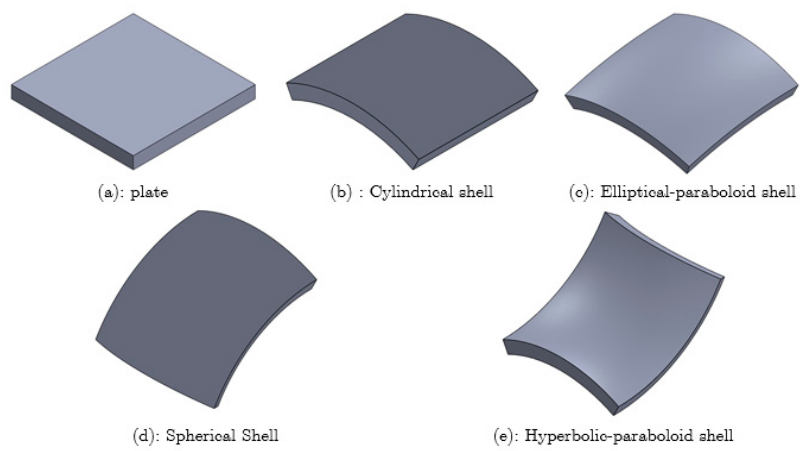
Figure 3. Forms of various plate/shells.